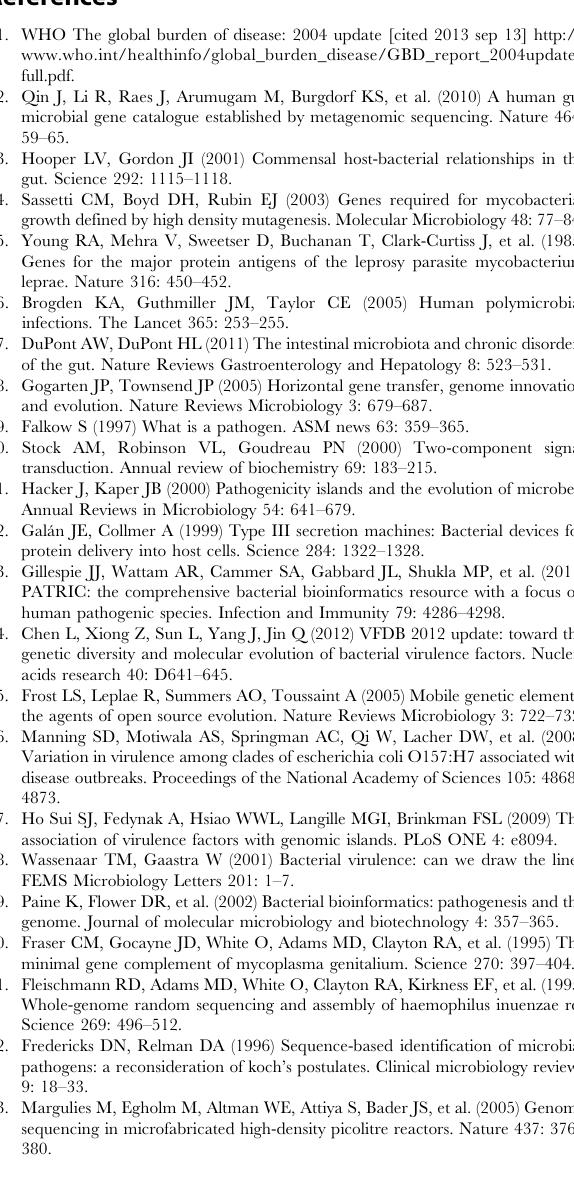
Table S3 Comparison with other methods. xlsx file containing a detailed description of the comparison of Pathogen- Finder and the method described in